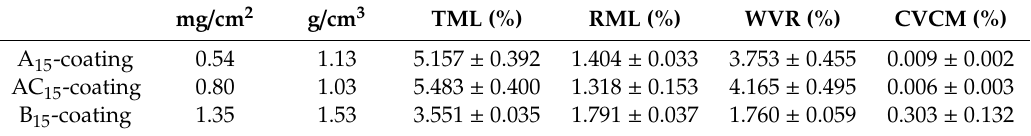
Table 5. Outgassing parameters of coatings deposited at 15 cm / min from the sols A, AC and B. mg / cm 2 g / cm 3 TML (%) RML